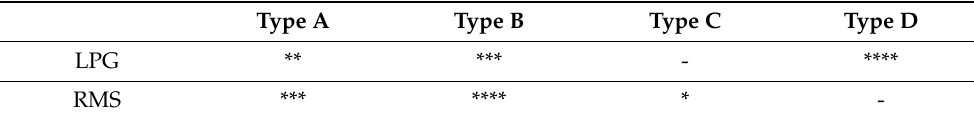
Table 4. TukeyHSD tests’ result for lane width